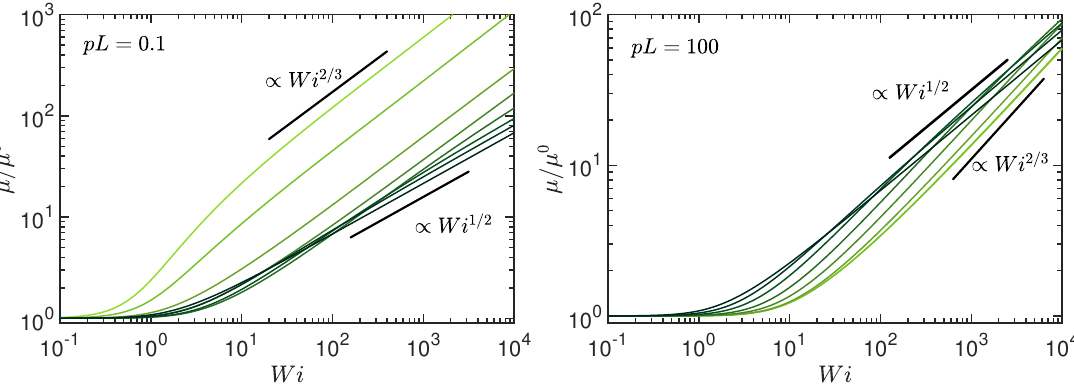
Figure 2. Stretching coefficient µ = 2 λ /3 p normalized by the value µ 0 of the active, non-sheared system as function of the Weissenberg number Wi for the Péclet numbers Pe = 0, 0.6, 3, 10, 30, 10 2 ,3 × 10 2 , and ∞ (bright to dark color); ( left ) pL = L /2 l p = 0.1 (stiff) and ( right ) pL = 10 2 (flexible polymer). The number of active sites is L / l = 10 2 and the diffusion coefficient ratio ∆ = 0.3.